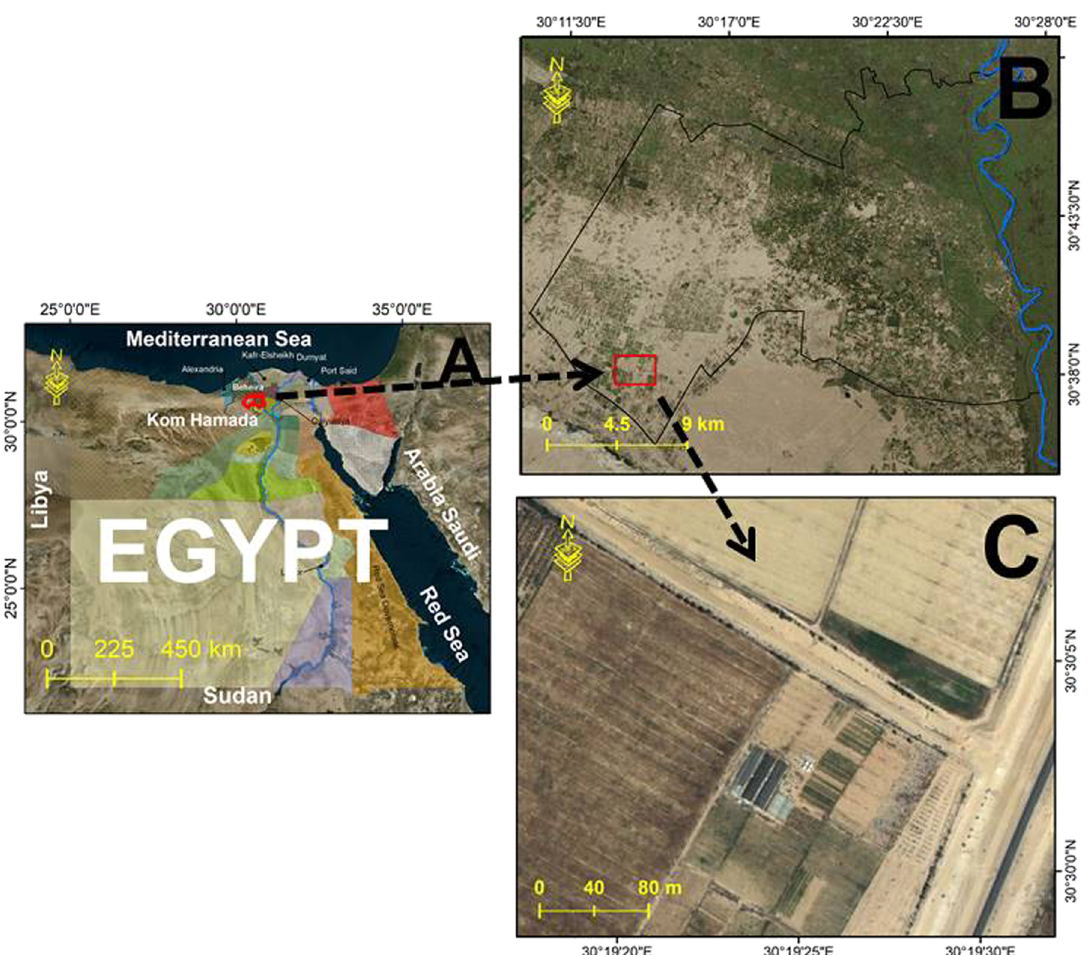
Figure 1: Location of the experimental area; Egypt ( a ) , El - Nubaria District ( b ) , NRC Farm ( c )